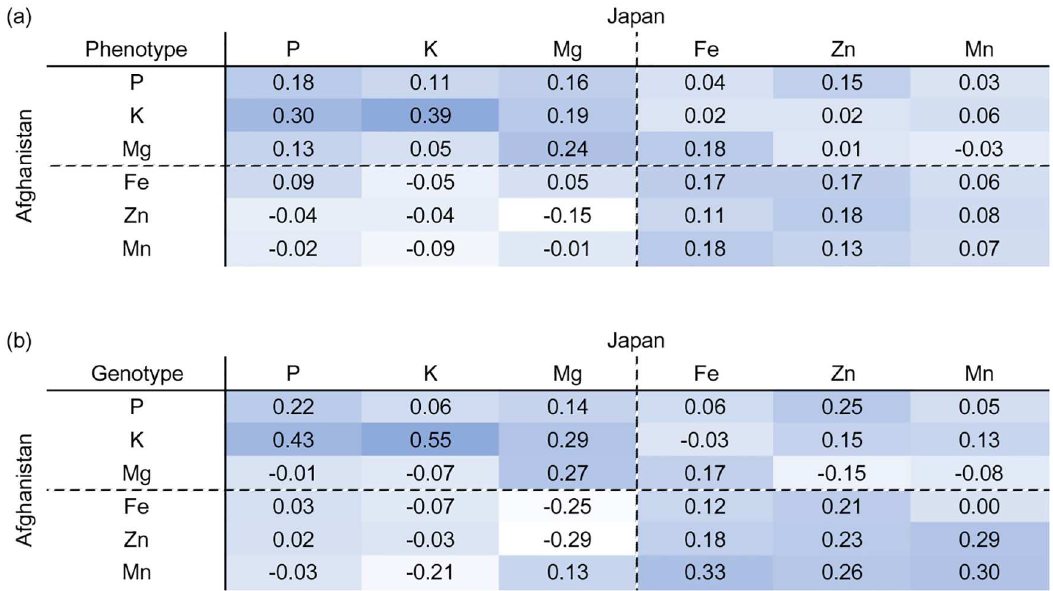
Fig 2. Phenotypic (a) and genetic (b) correlations between locations for all elements. The degreeof correlationis indicatedby blue color scale intensities.